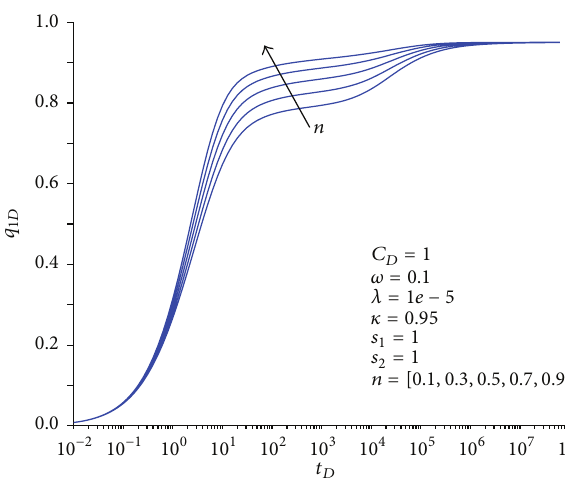
(1) Without Formation